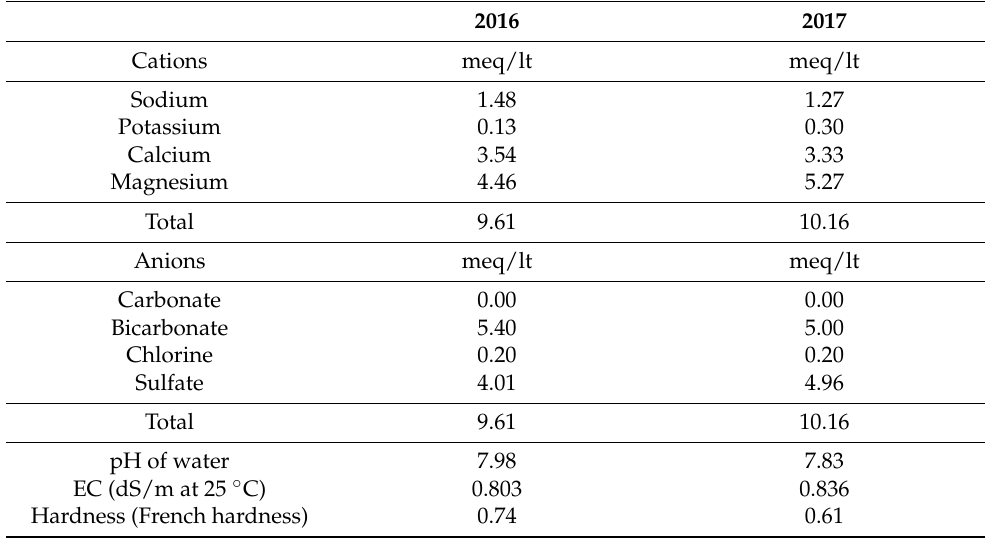
Table 11. Irrigation water quality in 2016 and